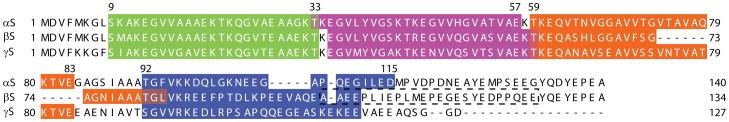
Synuclein proteins sequences.The various regions probed here are indicated by the colored boxes: green – AH construct (88% identity between αS and βS and 80% identity between αS and γS); purple – LF construct(74% identity between αS and βS and 59% identity between αS and γS); orange – NAC construct (48% identity between αS and βS and 41% identity between αS and γS); and blue – CT construct (27% identity between αS and βS and 25% identity between αS and γS). The sequence enclosed by the dashed line corresponds to an additional proline-rich construct (residues 102 to 126) probed in the C-terminal region of βS.